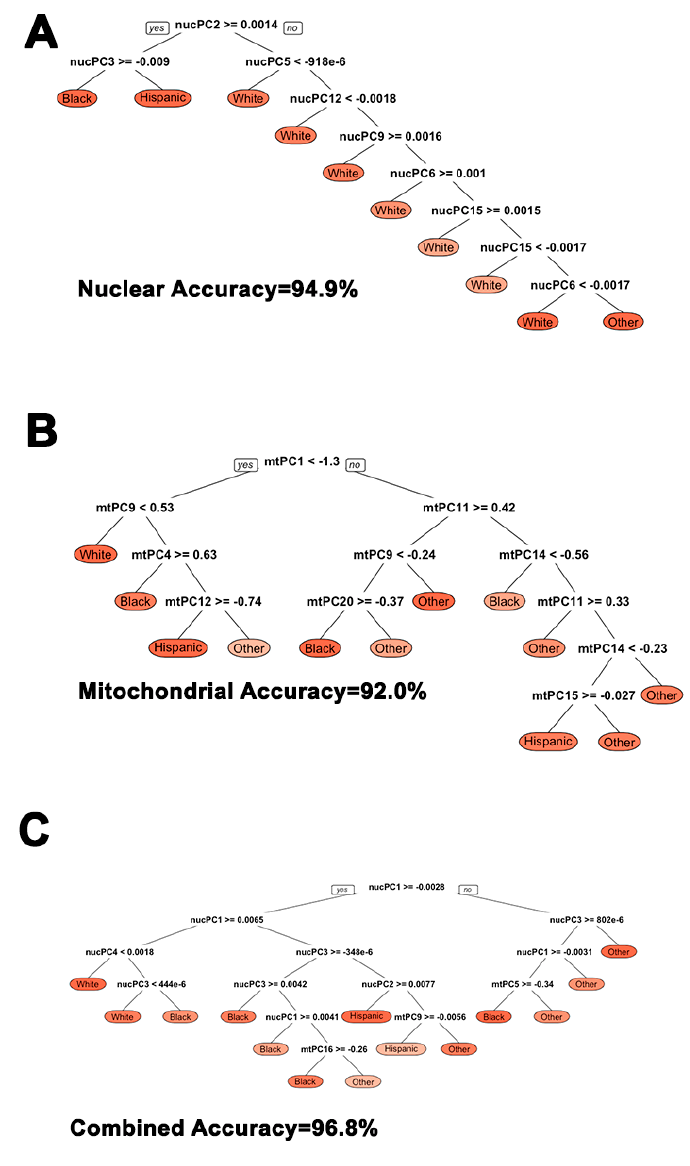
Figure 4. Comparison of nuclear, mitochondrial, and combined nuclear/mitochondrial PCA for statistically classifying individuals into broader ethnic sub-groups. ( A ) nucPCA shows a statistical classification accuracy rate of 94.9%; ( B ) mtPCA shows a statistical classification accuracy rate of 92.0%; ( C ) Combined nuclear and mtPCA shows a statistical classification accuracy rate of